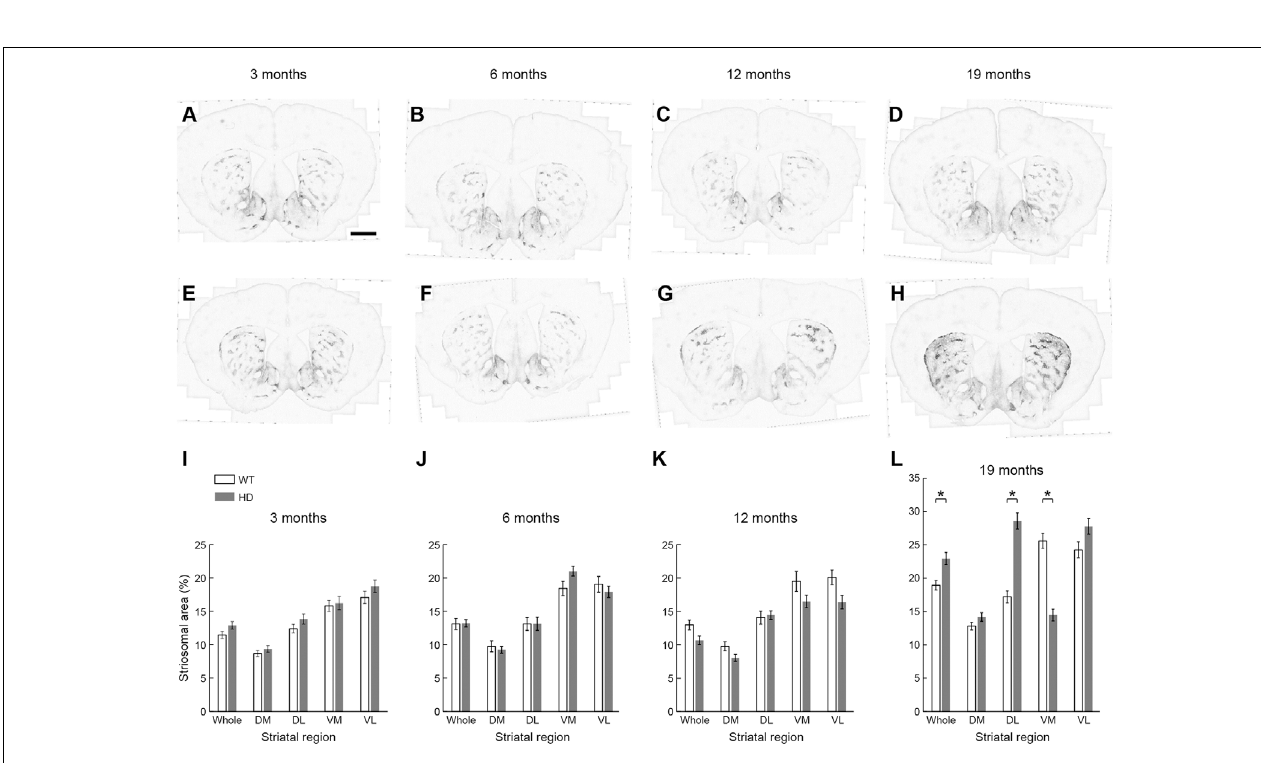
FIGURE 4 | Histological evaluation of the MOR1 labeling across four different ages (3, 6, 12, and 19 months) in the whole, dorsomedial (DM), dorsolateral (DL), ventromedial (VM), and ventrolateral (VL) regions of the rostral caudoputamen of WT and Q175KI mice. The background signals were subtracted using the “Rolling Ball” command (radius = 500 pixels) of Fiji software. At 3, 6, and 12 months of age (WT: A–C , Q175KI: E–G ), there was no difference between the size of the MOR1-positive striosome zones between WT and Q175KI mice (I–K) . By 19 months of age, the total MOR1-immunoreactive area increased in Q175KI mice (H) relative to WT mice (D) when either the whole ( p = 0.001) or the dorsolateral ( p < 0.001) caudoputamen was examined (L) . However, the total MOR1-immunoreactive area decreased in the ventromedial caudoputamen ( p < 0.001; D,H,L ). Asterisks indicate significant differences ( p < 0.005 after Bonferroni correction). Processed images were inverted. Scale bar = 1